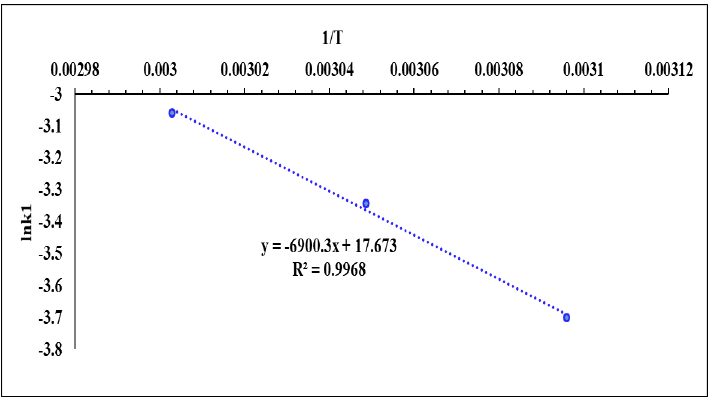
Figure 11. Plotting reaction kinetics in the Arrhenius equation for WCO esterification. Comparing Figure 11 with the Arrhenius equation, the following results can be ob- tained: frequency factor, A f = 4.73 × 10 7 and activation energy, Ea = 57,369.09 J/mol or 57.36909 kJ/mol.